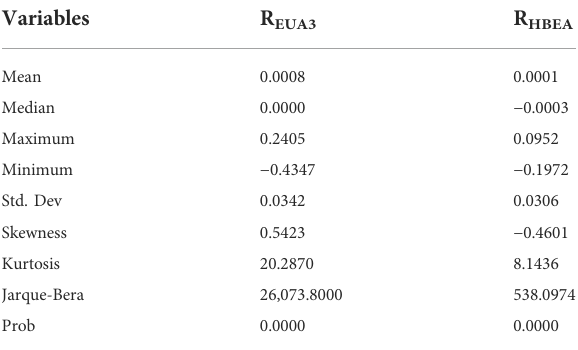
TABLE 2 Data descriptive statistics. This table presents the descriptive statistics results of carbon price returns considered for the whole sampleperiod.JBdenotestheJarque-Berateststatisticforthenullof